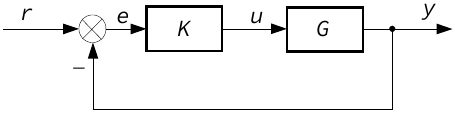
Figure 1. Feedback control Figure 1 . Feedback control system.